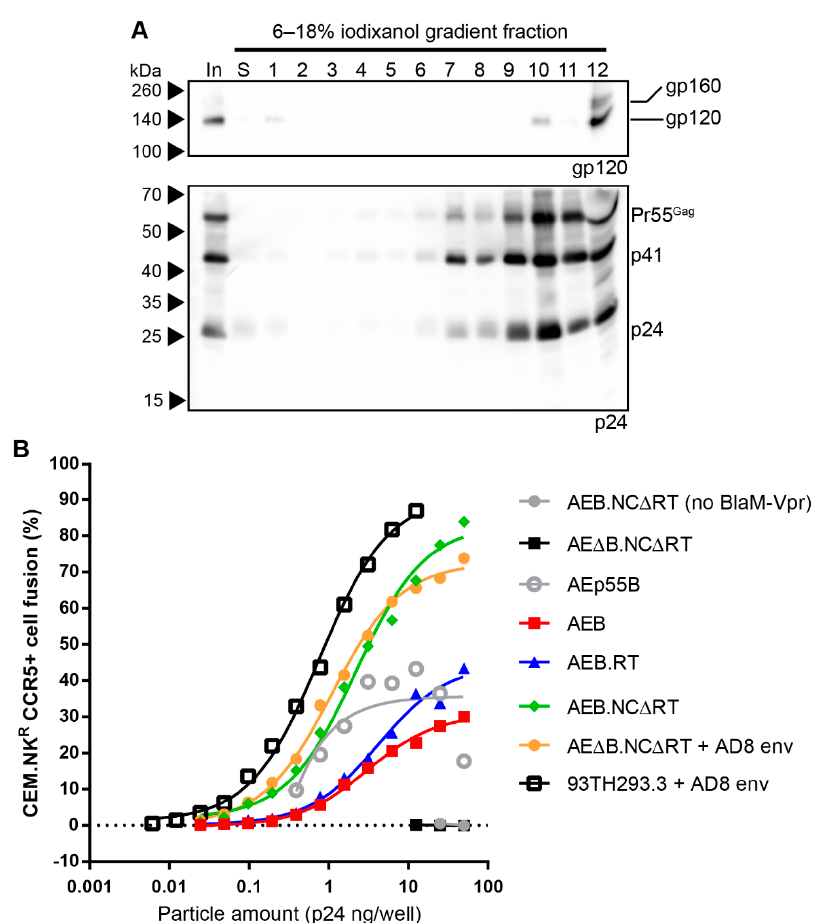
Figure 8. Rate velocity centrifugation and fusibility of AEB.NC Δ RT VLPs. ( A ) AEB.NC Δ RT VLPs were subjected to rate velocity centrifugation. A sample of the concentrated particles prior to centrifugation (In), the low-density fraction containing the particles prior to centrifugation (S), and gradient fractions of increasing density (1–12) were collected and resolved by 6–18% SDS-PAGE before Western blotting using anti-gp120 (DV-012, upper panel) and anti-p24 (BC1071, lower panel). The position of Env and the Gag polyprotein cleavage products are indicated on the right and protein sizes were indicated on the left by Spectra Multicolor Broad Range Protein Ladder. ( B ) Viral fusion assays were performed on various VLPs and the parental 93TH253.3 virus all of which were incorporating B clade Env (AD8 strain) (except for AEB.NC Δ RT Δ env that lacks a functional Env). Endpoint fusion was assessed for varying amounts of particle inputs indicated, as determined by p24 ELISA. The loading of AEp55B VLPs was determined by gp120 Western blotting and was normalized to the highest gp120-containing sample loaded (AEB.RT) and plotted using the corresponding p24 concentrations (sample gp120/p24 concentration ratios detailed in Table S2). Values represent the mean of duplicate samples.